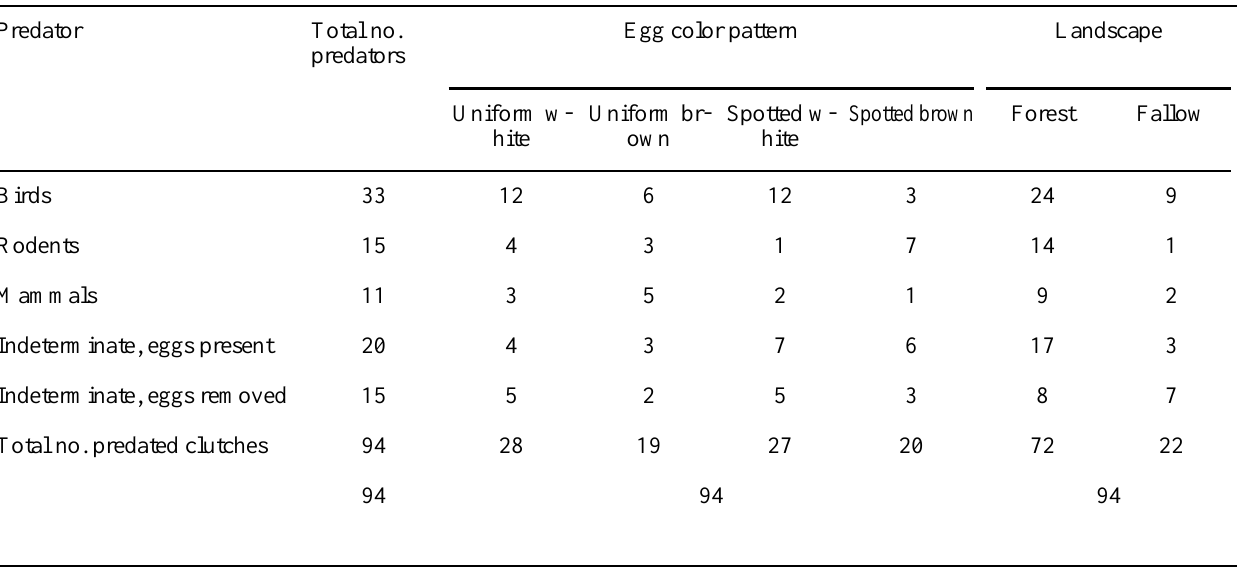
Predator Total no.